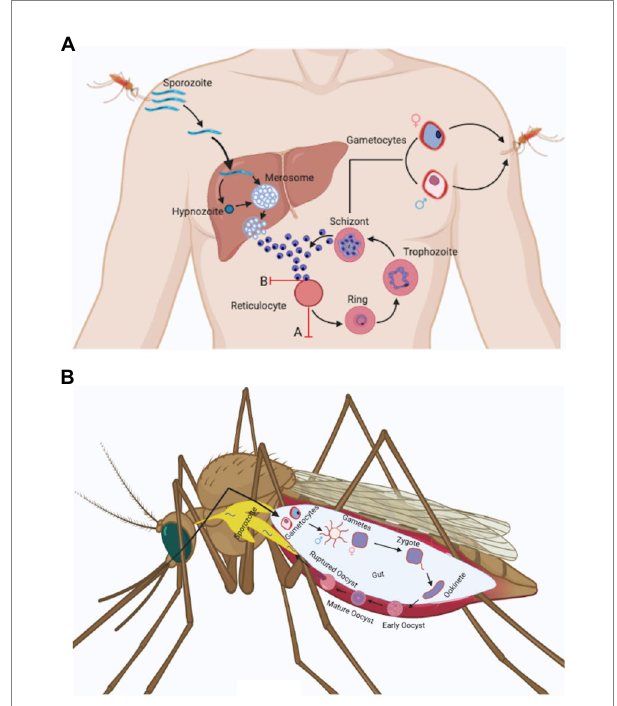
FIGURE 1 Plasmodium vivax life cycle. (a) Anopheles spp. mosquito inoculates Plasmodium sporozoites into the dermis of human skin that migrate to blood stream and finally invade liver. In the liver, Plasmodium sporozoites differentiate either into schizonts or into a dormant form called as hypnozoites that can activate after months or years and release merozoites. Plasmodium vivax hepatic merozoites invade reticulocytes in the bloodstream and start the formation of caveola- like complexes that helps in the completion of blood schizogony. Some of the asexual parasites undergo gametocytogenesis and form rounded gametocytes (after 4 days of infection) that are sucked up along with blood meal by another Anopheles mosquito (Bourgard et al., 2018). Two major obstacles associated with Plasmodium vivax in vitro culture are shown in the figure with red marks. These